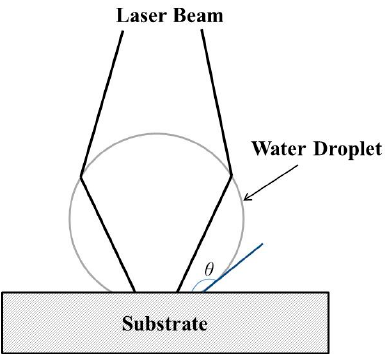
Figure 1. Schematic view of laser direct nano-structuring technology.